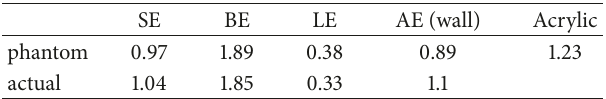
Table 3: Measured average density values of key phantom compo- nents vs. actual reported values from literature (g/cm 3 ). SE BE LE AE (wall) Acrylic phantom 0.97 1.89 0.38 0.89 1.23 actual